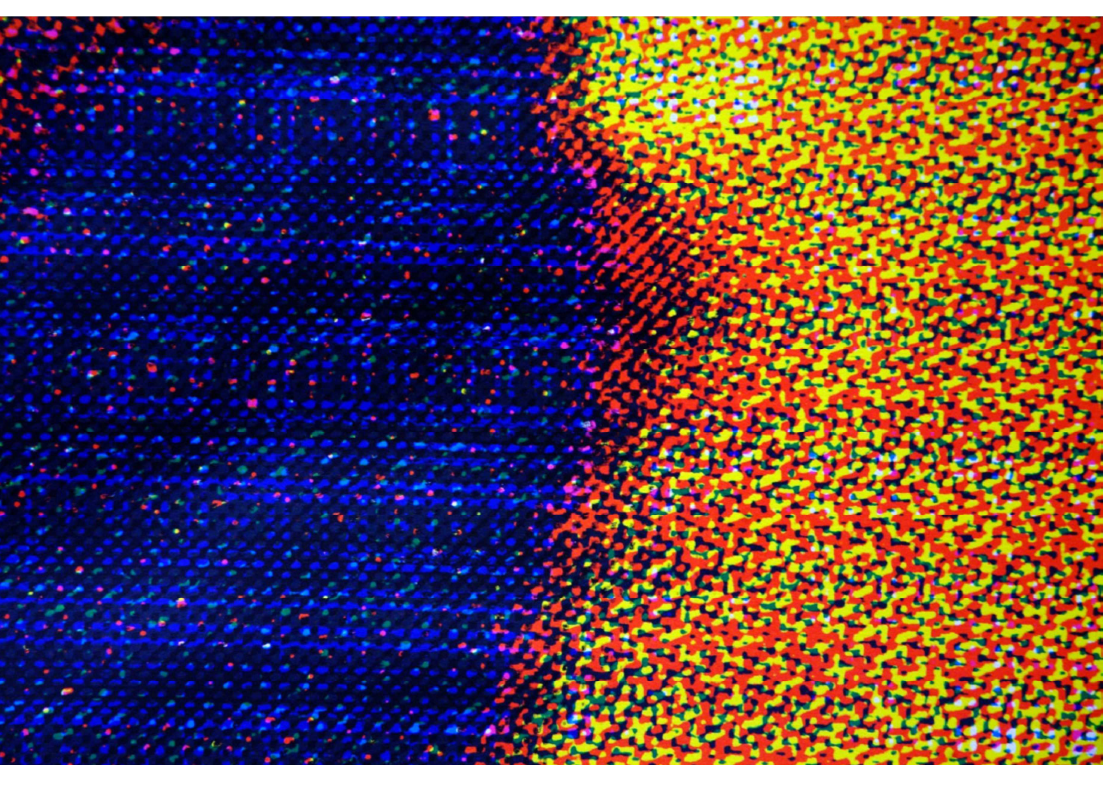
7: ‘Helen Knowles, 2012 detail of ‘Раждане с оргазъм’ Birth with orgasm http://www.youtube.com/watch?v=EDyUbZW29ts, Four Colour Screen’ print on Fabriano 1/3 95.5.cm x 146cm 2012 Edition of 3. Reproduced with the permission of the